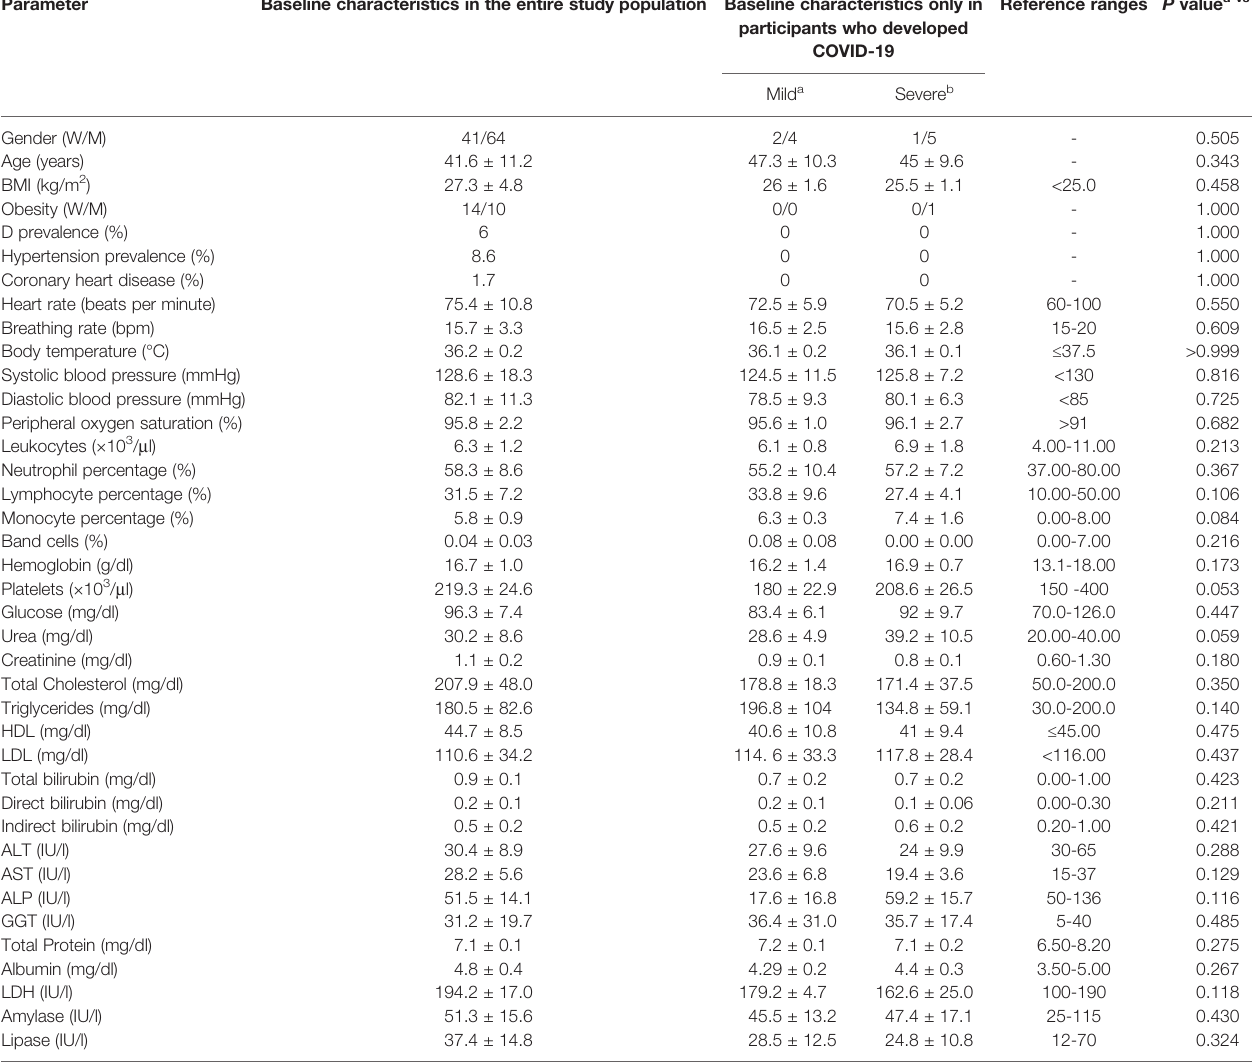
TABLE 1 | Baseline characteristics of the study participants.